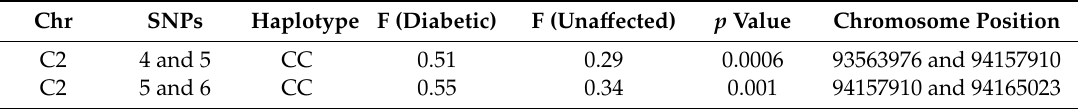
Table 3. Haplotype analyses . Data from the validation cohort were analysed using the haplotype association test implemented in PLINK. Results for the most associated haplotype are